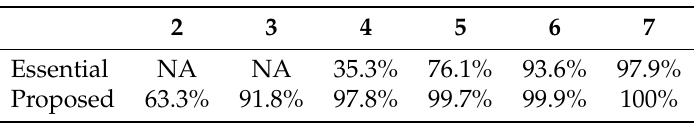
Table 3. Success percentages (number of successful estimations within 1000 experiments) of our method (proposed) and the method of Hödlmoser et al. [17] (essential). The first row represents the number of locations, and the first column gives the methods used for comparison. Each location yields 2 calibration samples (head and